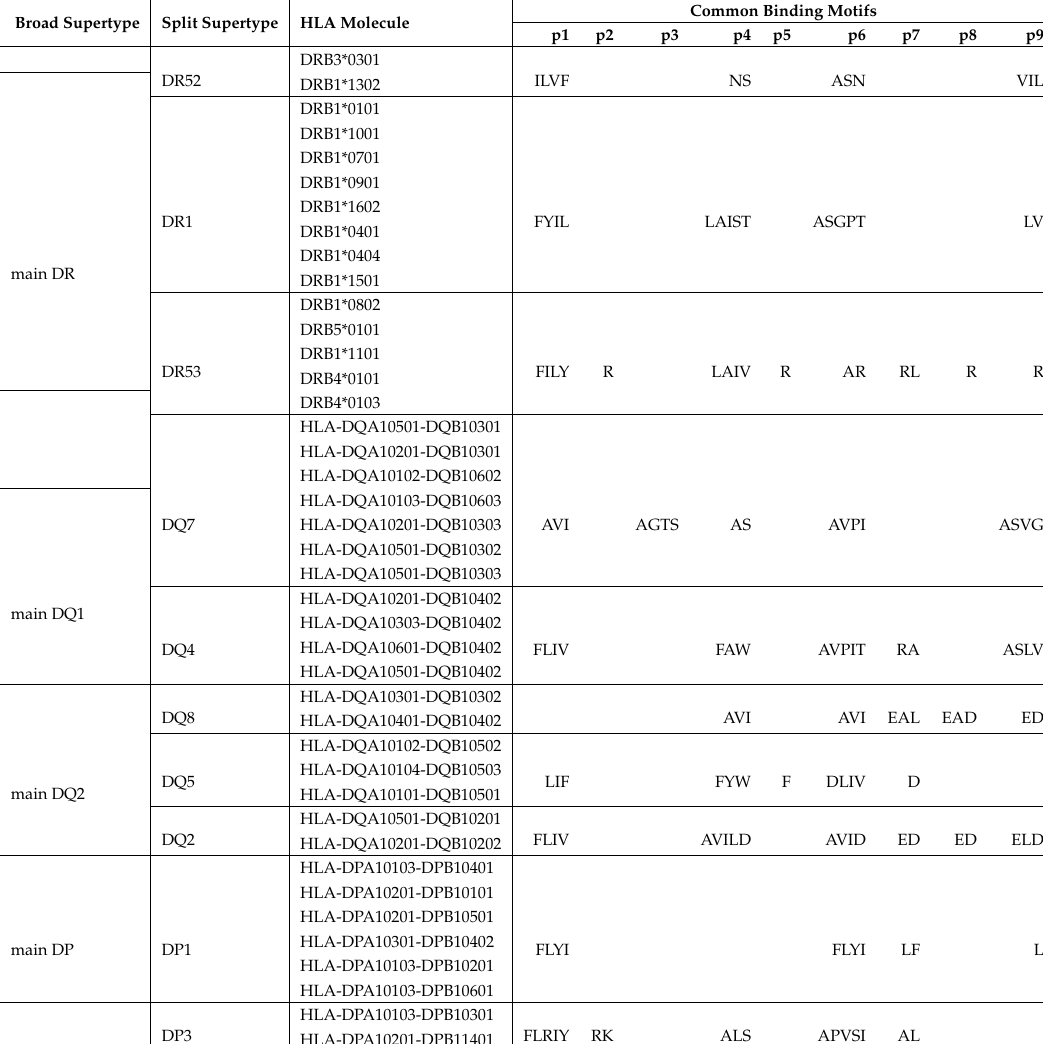
Table 2. Broad supertypes, split supertypes, and binding